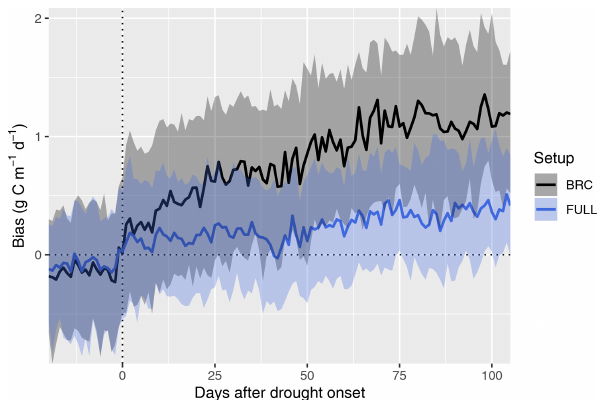
Figure 6. Bias in simulated GPP during the course of drought events. Simulated GPP is from a simulation with (FULL) and without (BRC) accounting for soil moisture stress. The timing of drought events is taken from Stocker et al. (2018) and is identified by an apparent soil-moisture-related reduction of observed light use efficiency at 36 FLUXNET sites. The bias is calculated as simulated minus observed GPP. Data from multiple drought events and sites are aligned by the date of drought onset and aggregated across all sites and events (lines for medians; shaded ranges from the 33% and 66%